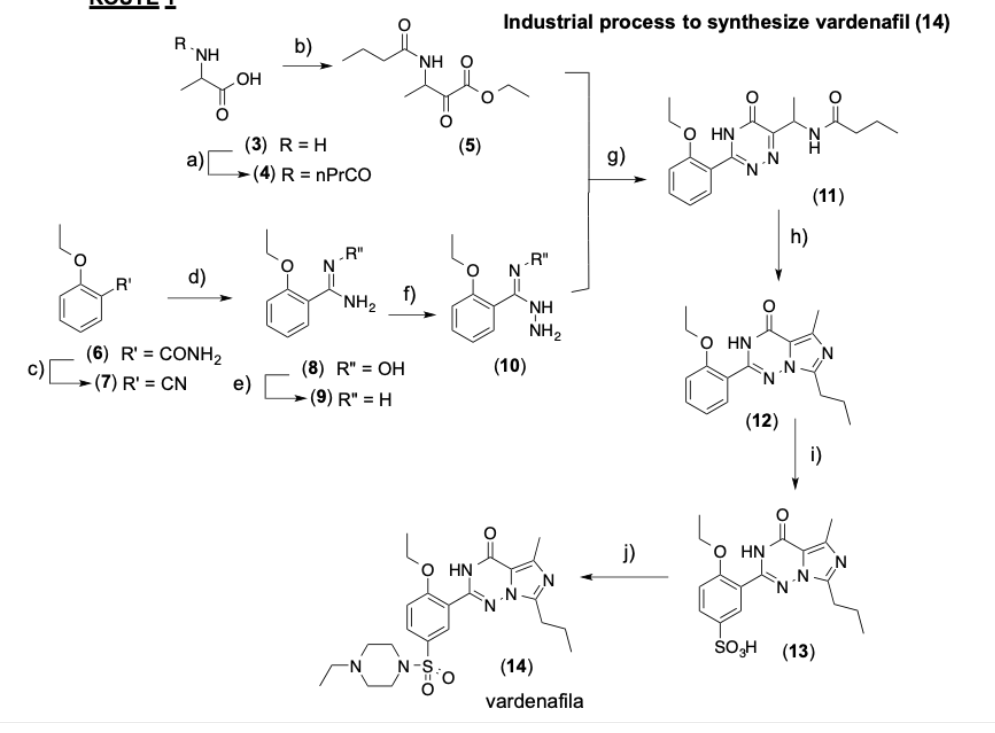
FIGURE 2 - Two industrial synthetic routes for vardenafil (14)